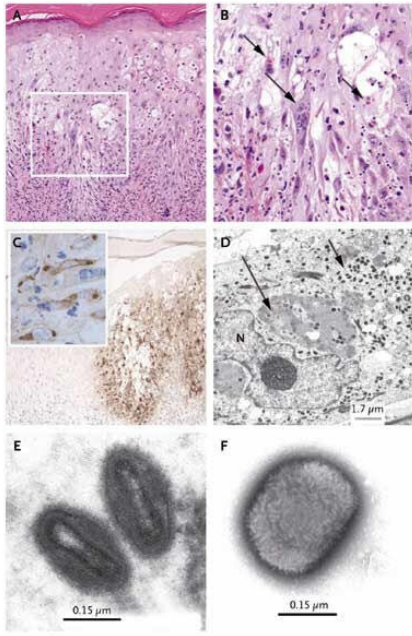
Figure 3. Histologic, Immunohistochemical and Ultrastructural Evaluation of the Skin ‐ Biopsy Spec ‐ imen from Patient. Panel ( A ) shows scattered degenerating and necrotic keratinocytes within the epidermis and a moderate inflammatory cell infiltrate within the epidermis and superficial dermis (hematoxylin and eosin, ×50). Panel ( B ) shows the boxed area in Panel A at a higher magnification (×200); a multinucleated cell (long arrow) and eosinophilic viral inclusion bodies (short arrows) are evident. Panel ( C ) shows immunohistochemical staining of orthopoxviruses antigen within the ep ‐ idermis (horseradish peroxidase with hematoxylin counterstain, ×40). The inset shows immunore ‐ activity within individual keratinocytes (×250). Panel ( D ) shows virions within the cytoplasm of a keratinocyte and includes immature forms that are being assembled (long arrow) and clusters of mature virions (short arrow). N denotes nucleus. Panel ( E ) shows virions with dumbbell ‐ shaped cores characteristic of poxviruses. Panel ( F ) shows a negatively stained virion from cell culture (phosphotungstic acid). The brick ‐ shaped particle has regularly spaced, thread ‐ like ridges on the exposed surface. Reprinted with permission from Ref. [3]. Copyright 2022 The New England Journal of Medicine. 5. Differential Diagnosis The World Health Organization lists smallpox, chickenpox, measles, bacterial der ‐ matosis, drug eruption and syphilis as diseases to be differentiated from monkeypox [32]. Smallpox and severe chicken pox are the most confusing diseases of monkeypox. The clin ‐ ical symptoms of monkeypox and smallpox are very similar, and the clinical manifesta ‐ tions of monkeypox and smallpox are difficult to distinguish because of the similar pro ‐ dromal period, eruption process and the distribution of a rash. Therefore, the enlarged lymph nodes peculiar to monkeypox is a key feature to distinguish between the two. Mon ‐ keypox is generally less severe than smallpox in terms of complications morbidity, mor ‐ tality, scab degree. Severe cases of varicella are often misdiagnosed as monkeypox, except for the char ‐ acteristic enlarged lymph nodes of monkeypox to distinguish the two, varicella usually has no obvious signs of fever, and the temperature during fever is usually lower than 38.8 °C. The skin lesions are centripetal, the lesions are smaller, involve the superficial surface and rarely involve the palms and soles of the feet, and the rashes on the torso are denser than those on the extremities and face. The progress of varicella lesions is faster than mon ‐ keypox: the former takes 3–5 days, while the latter takes an average of 12 days [49].